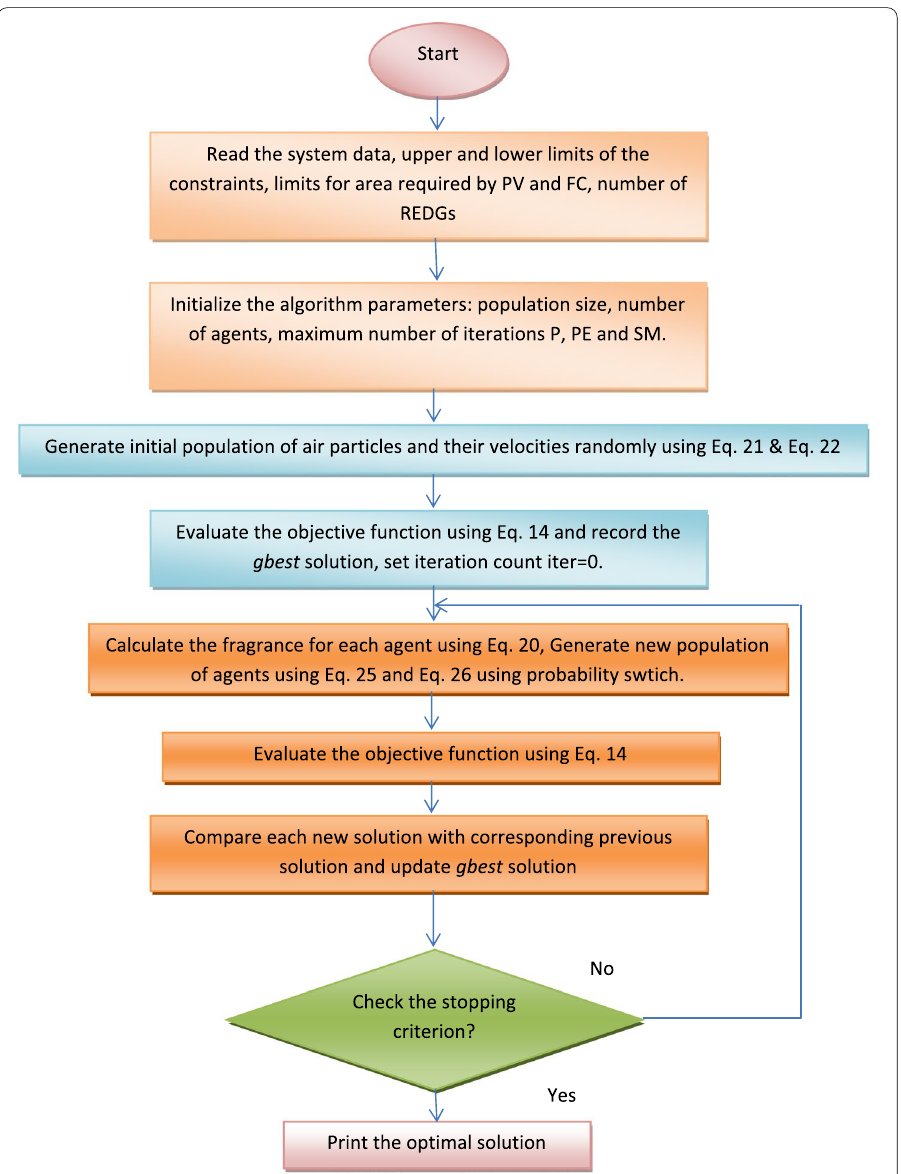
Fig. 1 Problem specific implementation flow chart of BO